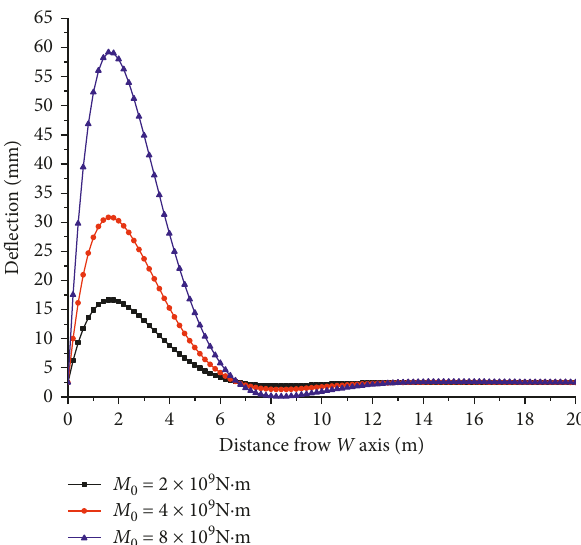
Figure 5: Distribution curves of anticlinal deflection with different foundation